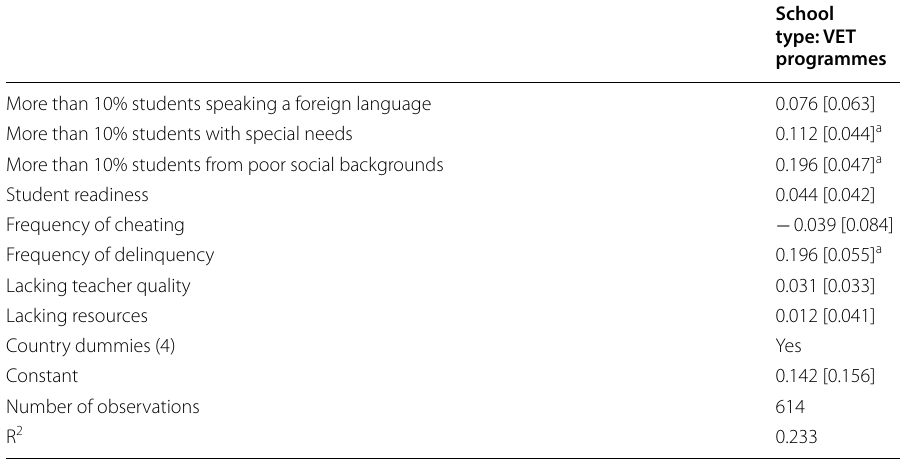
Table 5 Regressions results, weighted data, OLS (clustered standard errors in